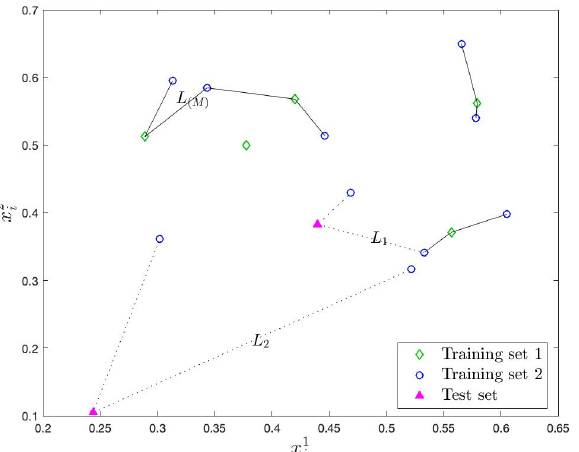
Figure 2. Proposed detection procedure with N 1 = 5, N 2 = 10, M = 4, k = 2, s = 1, γ = 1. ( L ) d − ( L ) d and ( L ) d − ( L ) d are used to update the test statistic s t and raise athen alarm at ( M ) ( M ) 2 1 time T , as shown in (1)–(4). Training and test points are generated from a bivariate normal distribution with independent components, 0.5 mean and 0.1 standard